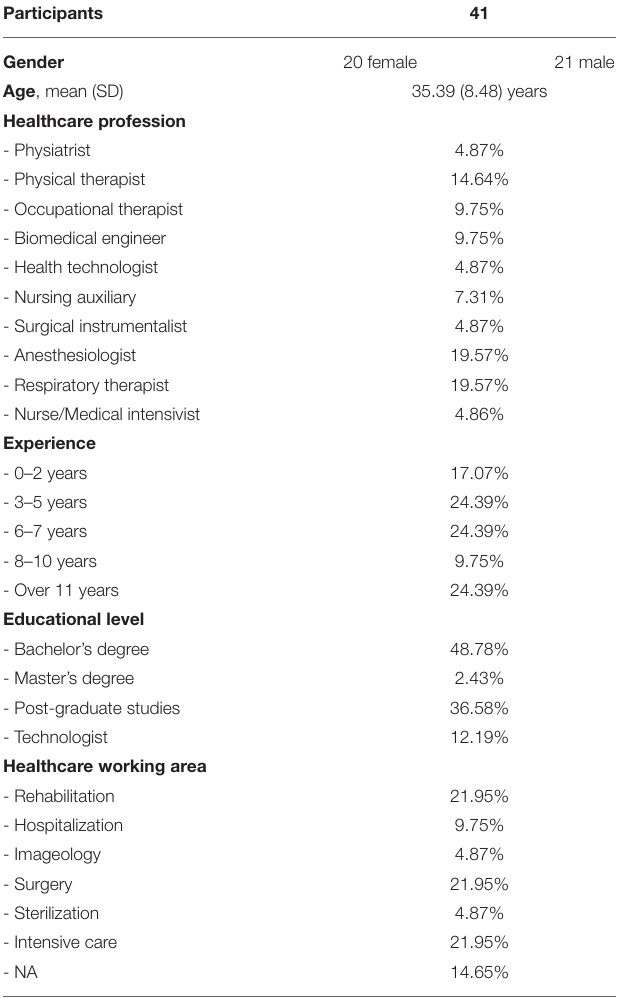
TABLE 6 | Demographic data of the healthcare personnel who participated in the